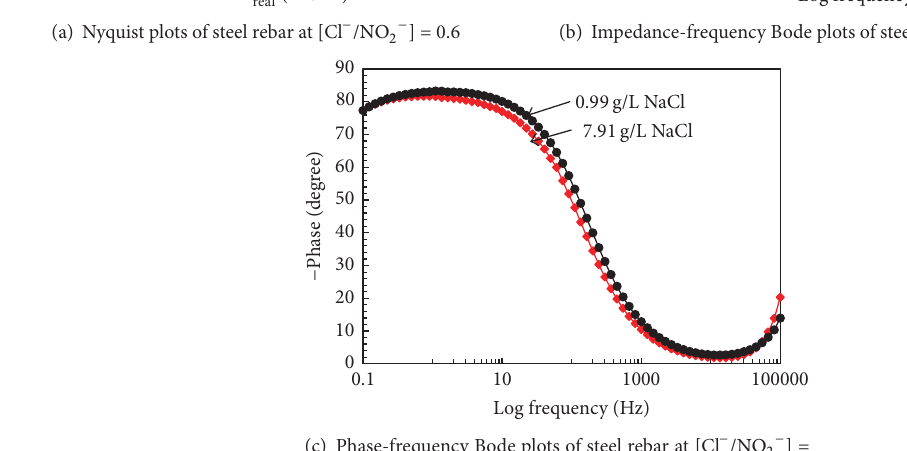
(c) Phase-frequency Bode plots of steel rebar at [Cl − / NO 2− ] = 0.6